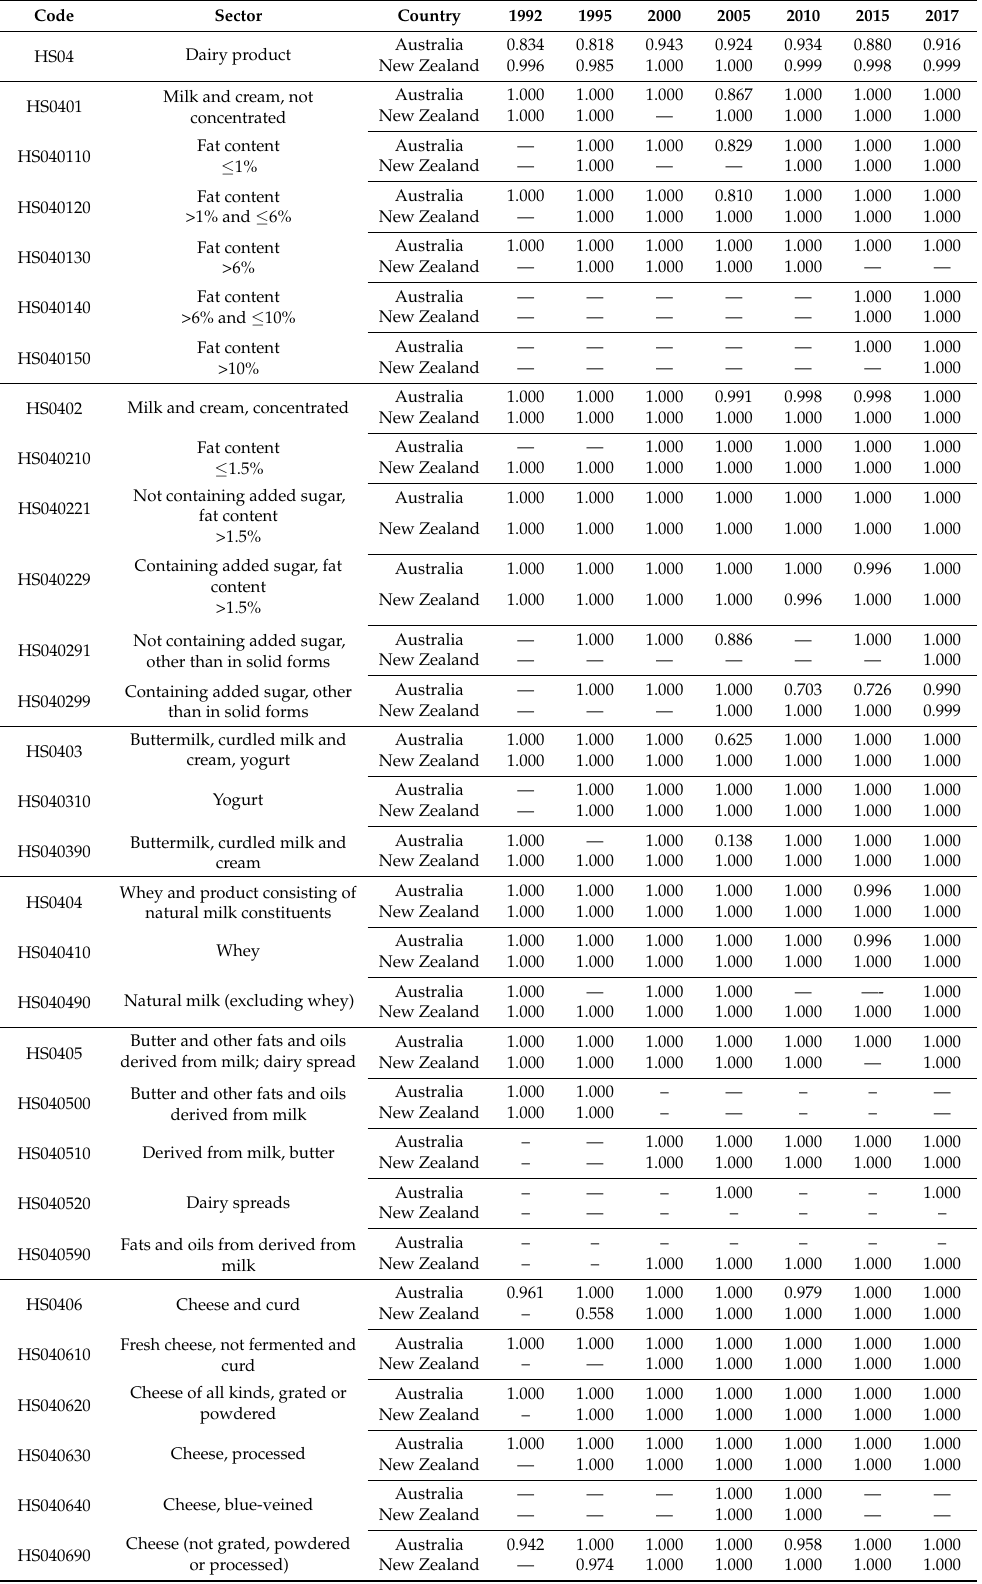
Table 5. Competition Index of Australia and New Zealand in China Market (competition index